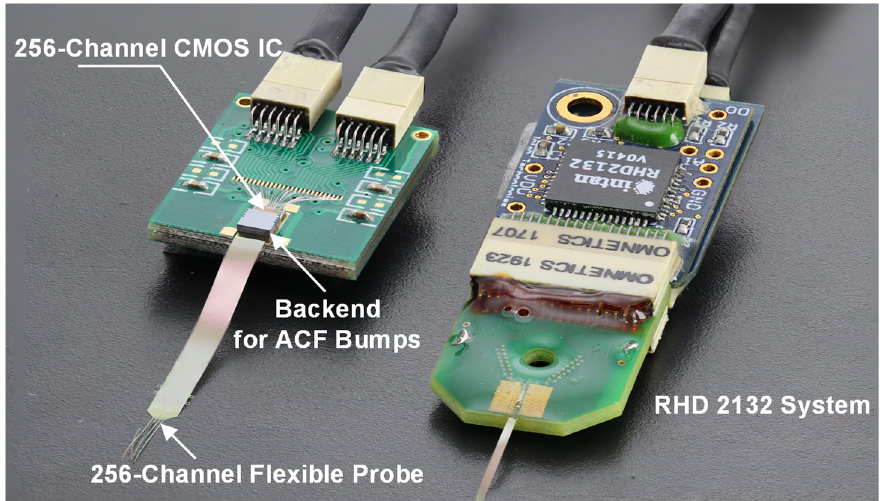
Figure 1. A high-density 256-channel neural recording system (left) where a 256-channel analog frontend circuit and flexible polyimide neural probe are hybrid-combined using anisotropic conductive film (ACF) [23]. A system where a commercial head-stage (RHD 2132, Intan Technology LLC, Los Angeles, CA, United States) and a 64-channel probe are assembled with two RHD 2132 chips is also shown for comparison.